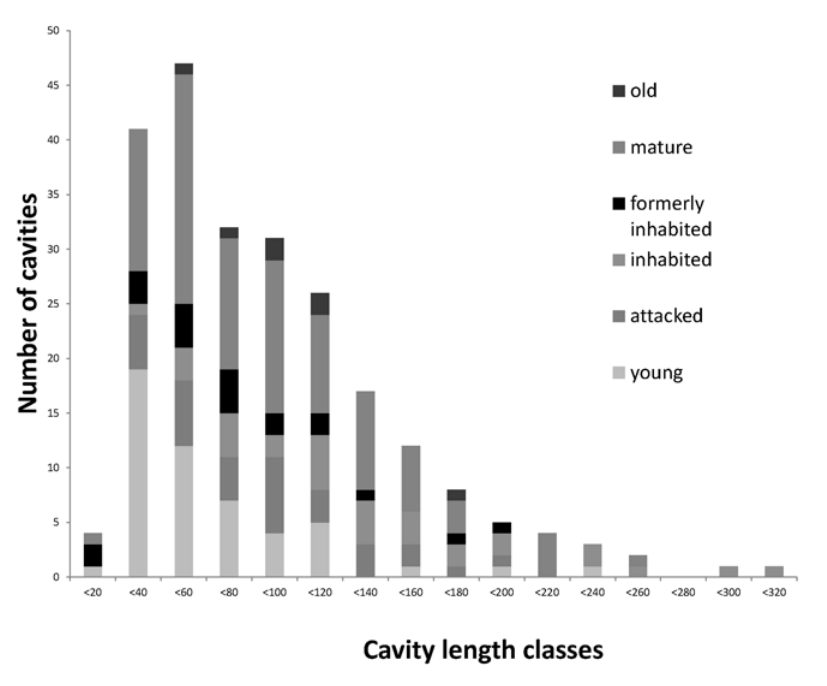
Fig. 2. Cavity length as a function of cavity type. Inhabited cavities are longer than